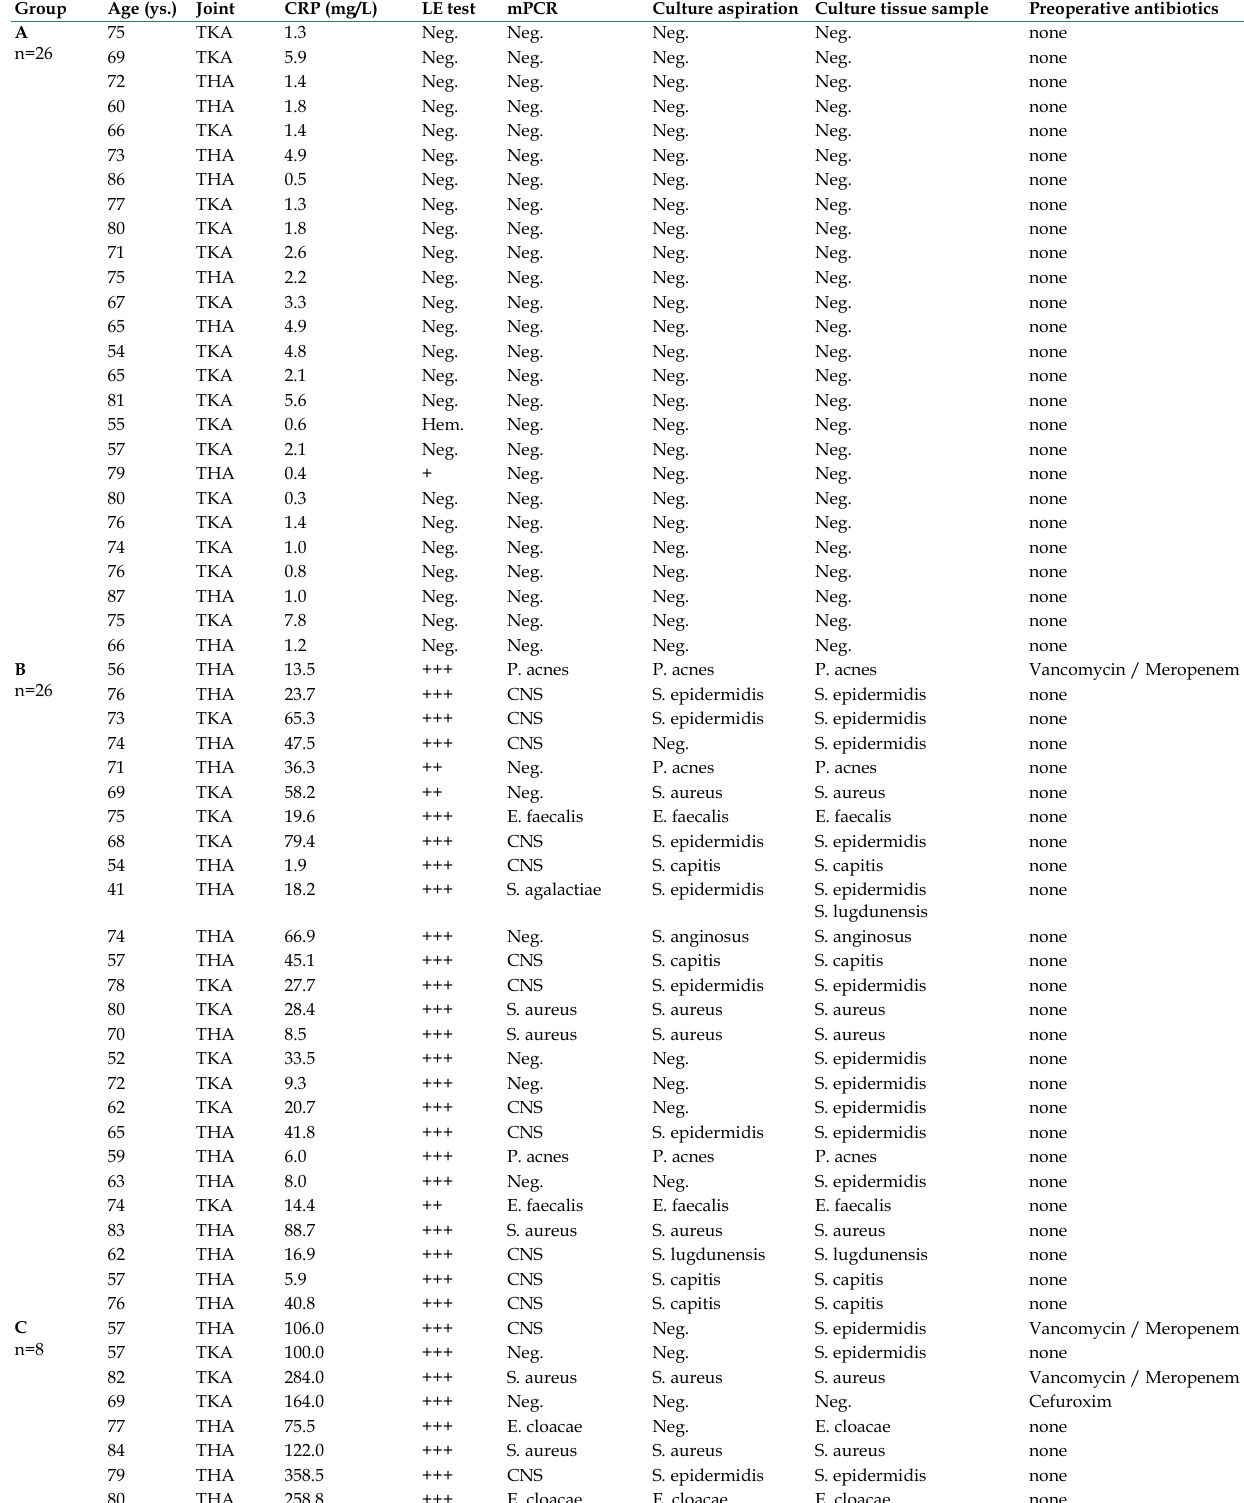
Table 2. Results of all study patients (n=60): the most important parameters of negative control patients (Group A), of patients with chronic PJI (Group B) and of individuals with acute PJI complicated with SIRS (Group C) are shown. Mismatch between results of mPCR and traditional cultures are highlighted with grey color. [CRP = C-reactive protein, LE = leukocyte esterase, mPCR =